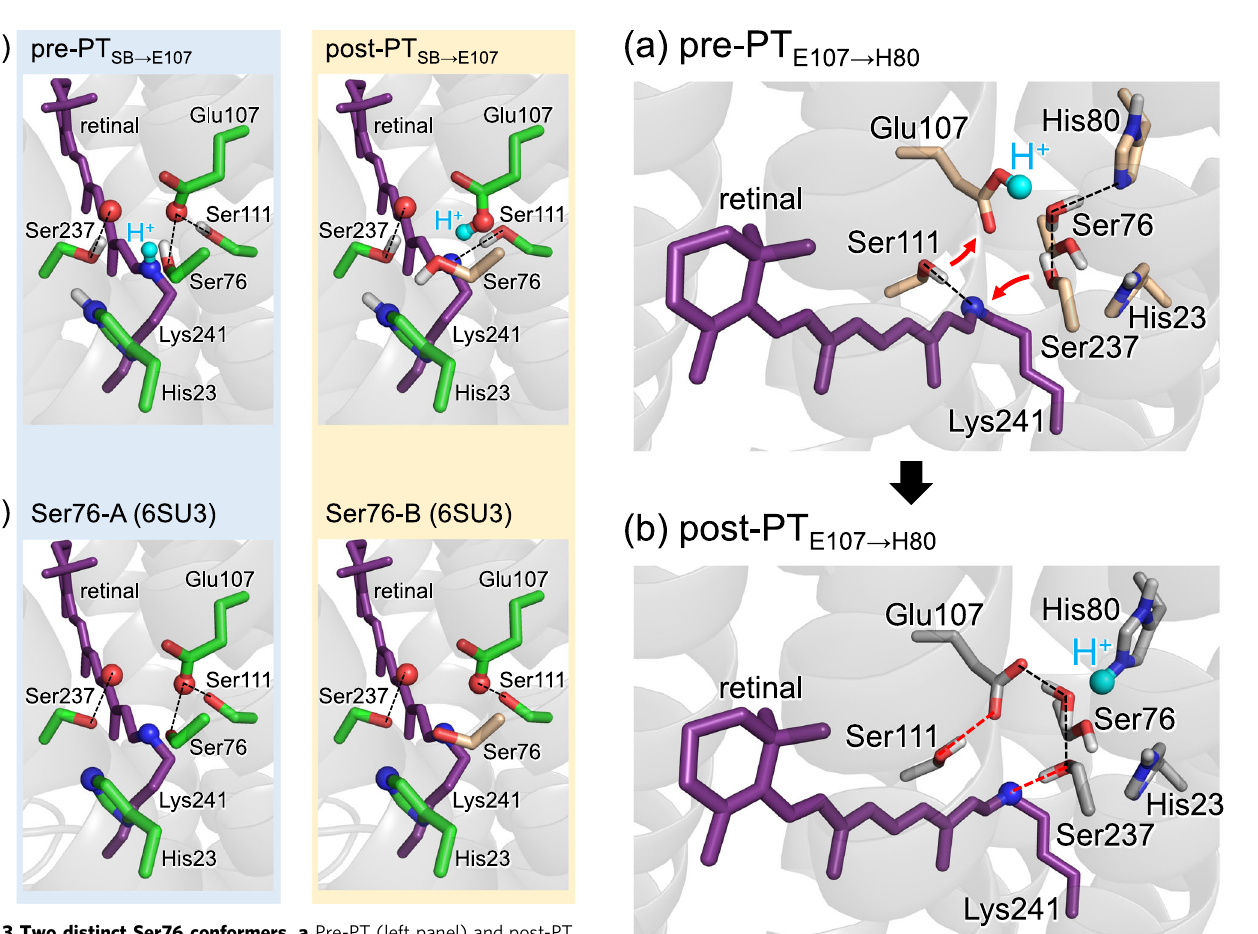
Fig. 3 Two distinct Ser76 conformers. a Pre-PT (left panel) and post-PT (right panel) conformations observed during proton transfer from the Schiff base to Glu107 in QM/MM calculations. b Ser76-A (left panel) and Ser76-B (right panel) conformations identi fi ed in the heliorhodopsin crystal structure (PDB code 6SU3) 6 . Dotted lines indicate H-bonds.